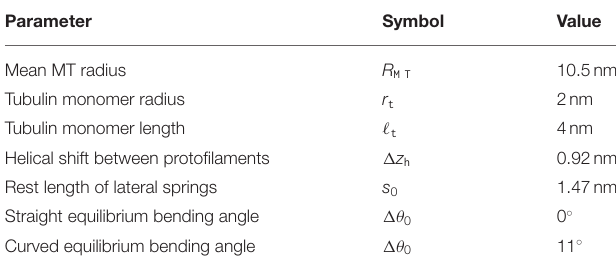
TABLE 1 | Geometric parameters of our MT